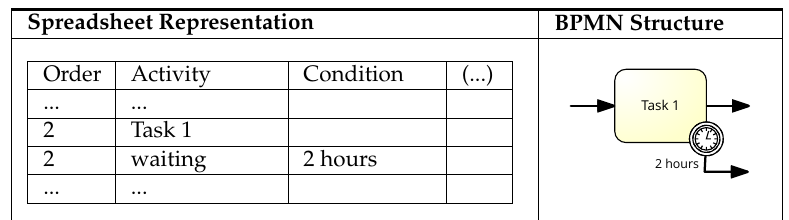
Table 7. Boundary intermediate